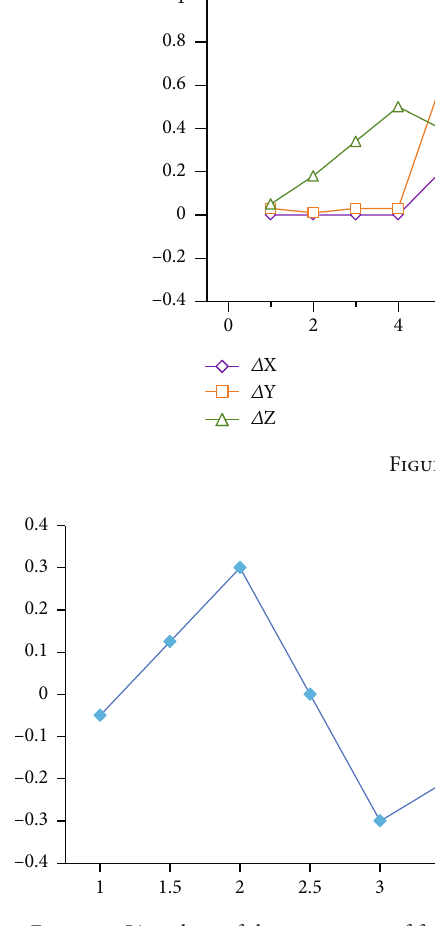
Figure 5: Line chart of the mean error of factor I.